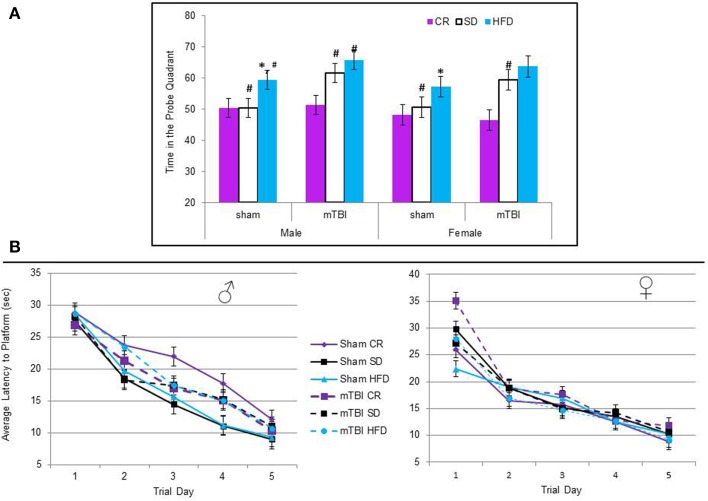
(A) Average percentage of time animals spent in the quadrant that had previously contained the hidden platform on the probe trial of the Morris water task. The protocol employed in this study utilized a 60 s probe trial; under these conditions, normal animals will typically spend the first 50% of their time searching in the area that previously contained the platform, but upon discovery that it is not there, switch strategies and search for the platform in other regions for the remaining 50% of the time. Animals on the HFD and STD spent significantly more time than would be expected in the platform quadrant if they had experienced an mTBI. In addition, male sham animals on the HFD also spent more time in the platform quadrant than the CR and STD sham animals (*p < 0.01; main effect of injury, #p < 0.01; main effect of diet). (B) There was no significant difference in the time it took animals to learn the location of the hidden platform over the 5 trial days, regardless of injury status or dietary intake (p > 0.05).